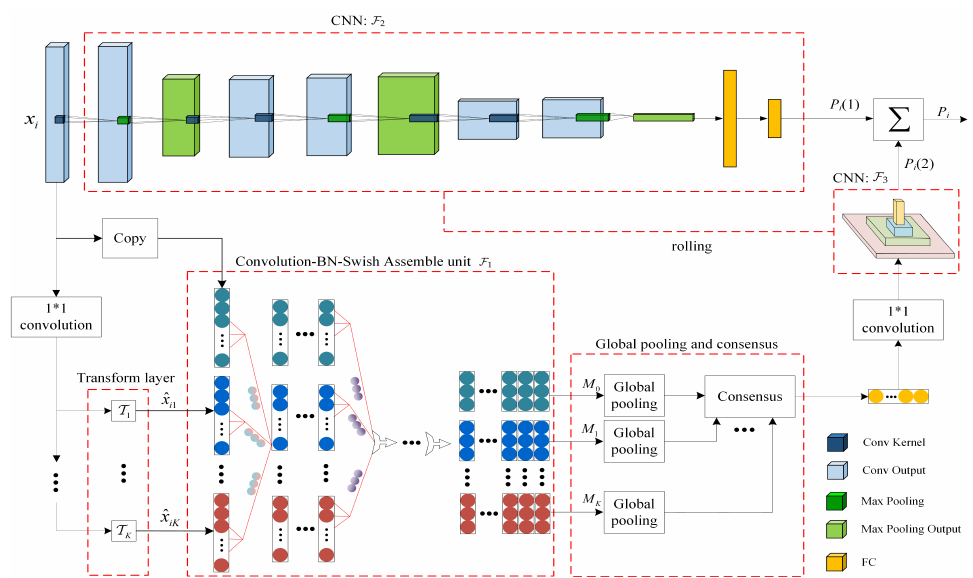
Figure 3. The MGRALN model for REC. Radar signal is supposed to transform layers, convolution- BN-Swish assembly, and temporal global pooling and consensus unit. After this, with learnable parameters shared between signal-based CNN and consensual response-based CNN, the final predic- tion is available by fusing P i ( 1 ) and P i ( 2 )